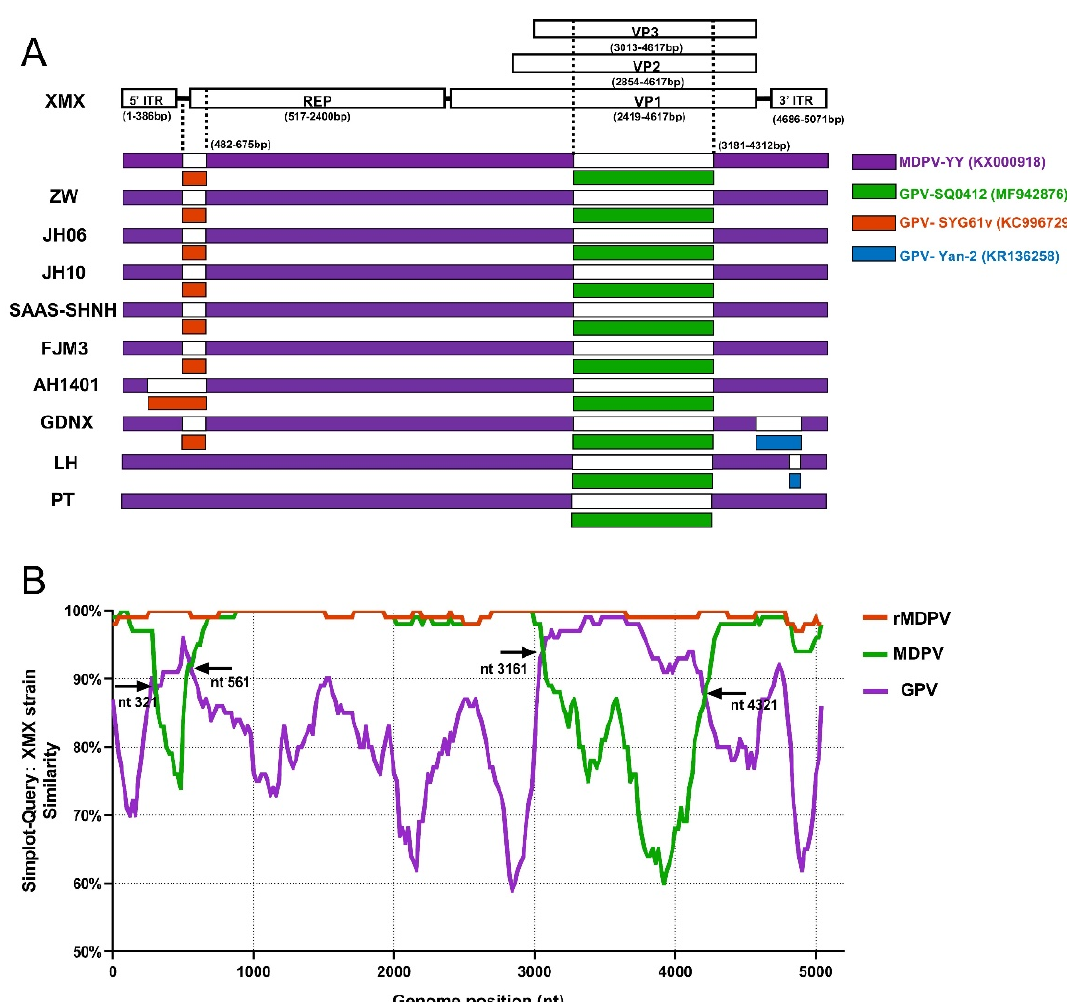
Figure 7. Recombination analysis based on complete MDPV and GPV genomic sequences on Gen- Bank. ( A ) Recombination analysis of WPFs generated by RDP 4.4.3; ( B ) Recombination analysis by